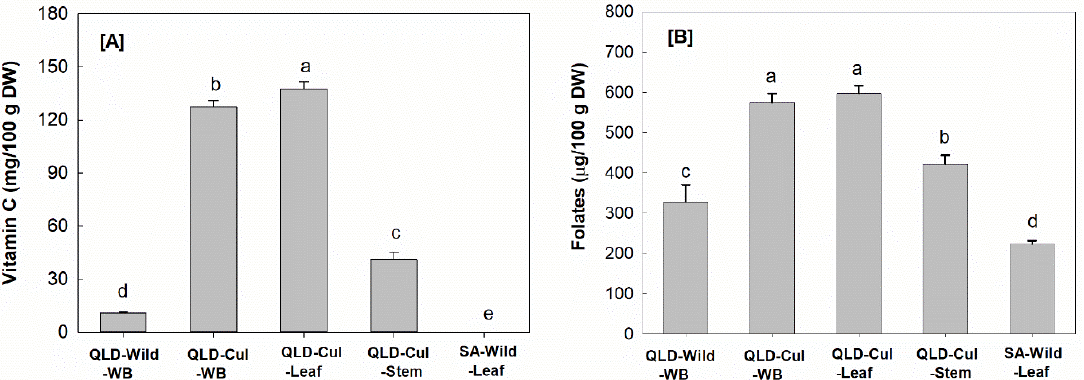
Figure 2. Contents of vitamin C ( A ) and folates ( B ) in the studied P. angustifolium samples; Data present means ± SD ( n = 3); Different letters indicate significant differences at α = 0.05; RDI for vitamin C and folates are reported at 45 mg/day and 400 µg/day for adults, respectively [34].